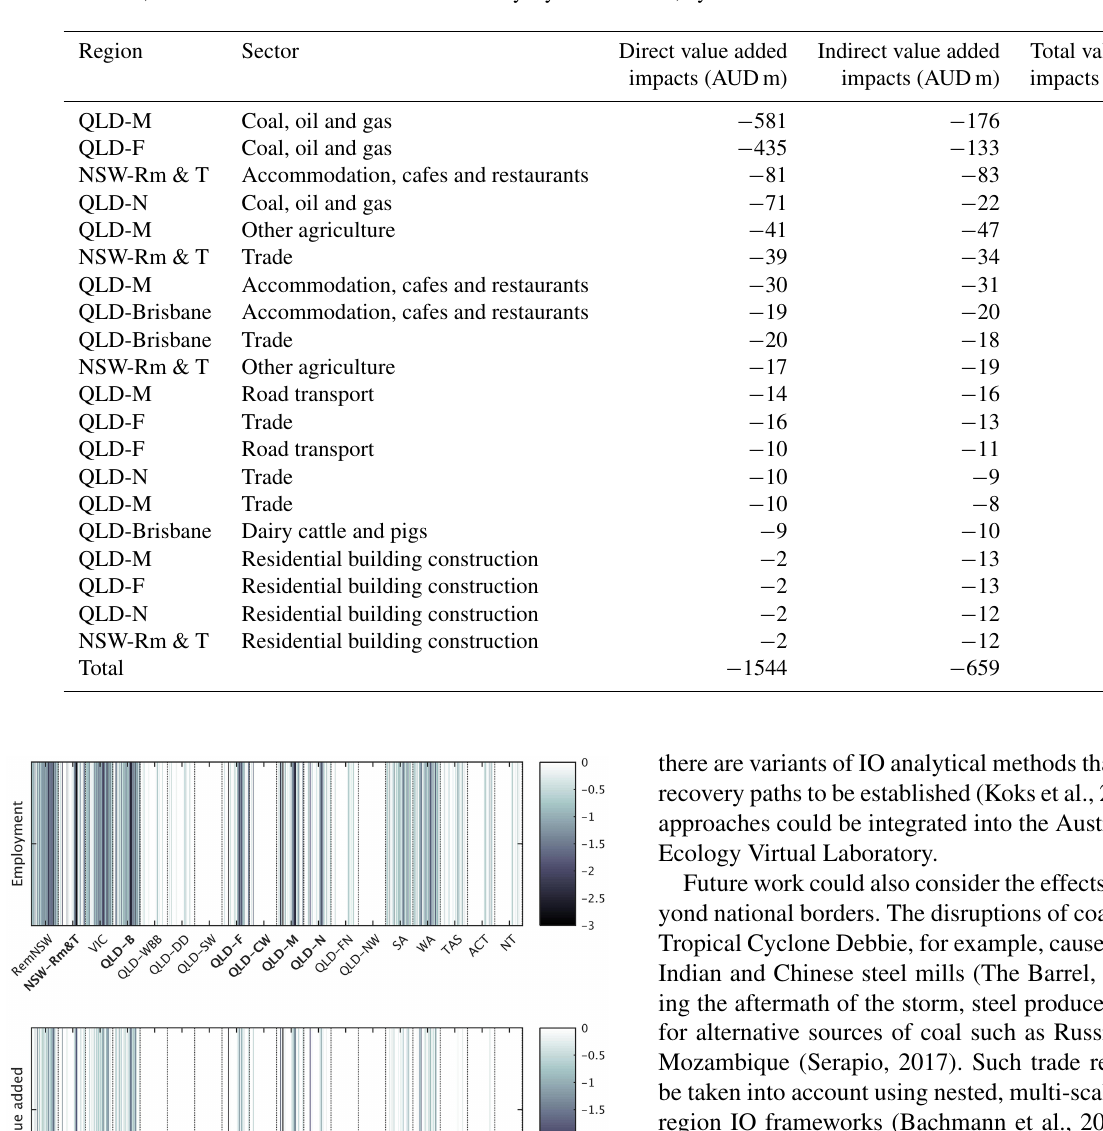
Table 5. Direct, indirect and total value added affected by Cyclone Debbie, by state and sector.